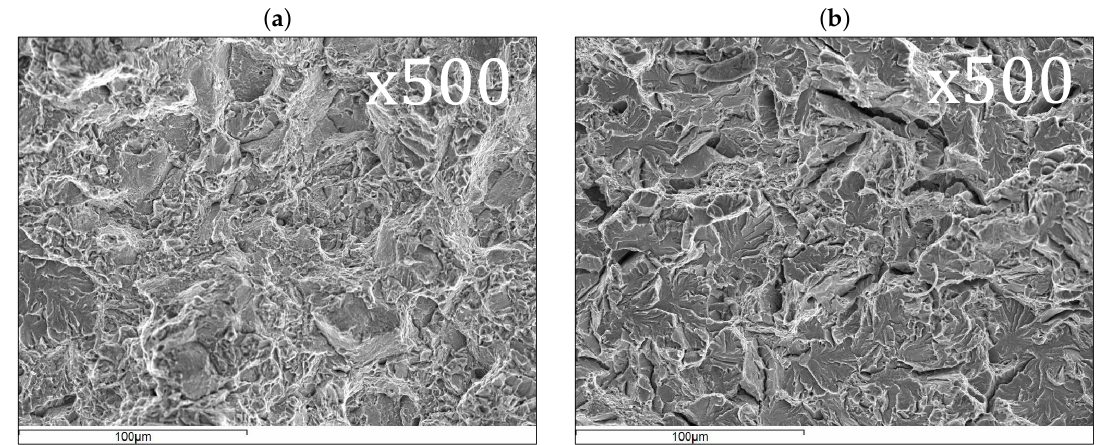
Figure 5. Fractographs obtained from the 9 mm-diameter specimen made of Material 1 [26]. ( a ) Detail of the central region. ( b ) Detail of the external region.